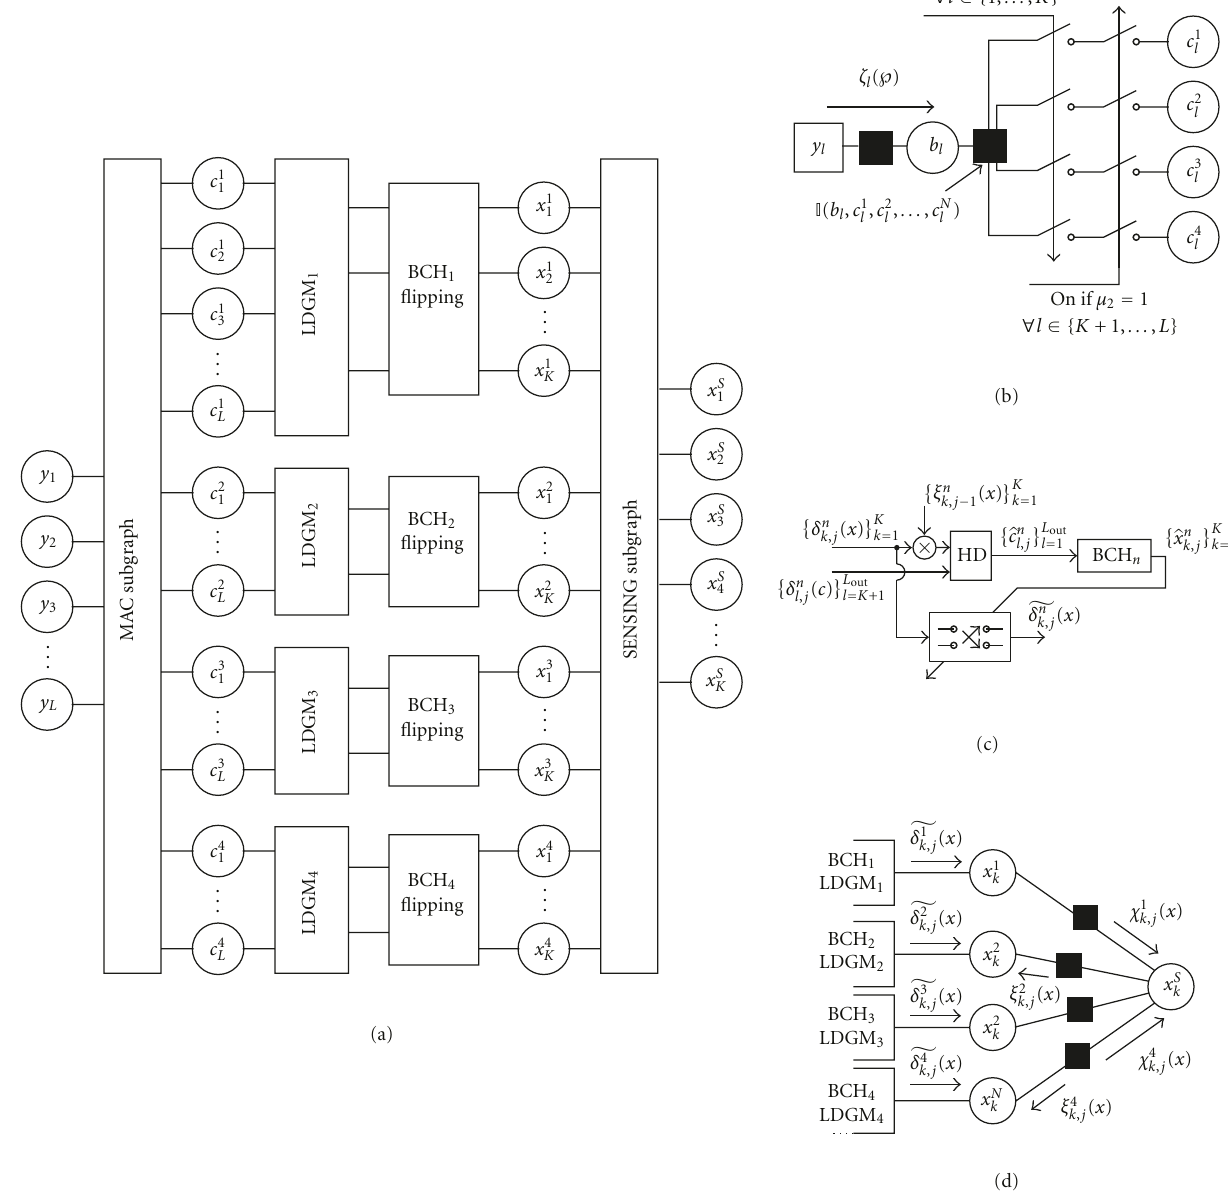
Figure 3: (a) Block diagram of the overall factor graph corresponding to the proposed iterative receiver; (b) MAC factor subgraph; (c) adaptive flipping of the exchanged soft information between the LDGM and SENSING subgraphs based on the output of the BCH decoder; (d) SENSING factor